Question: Author a descriptive caption for the visualization shown.
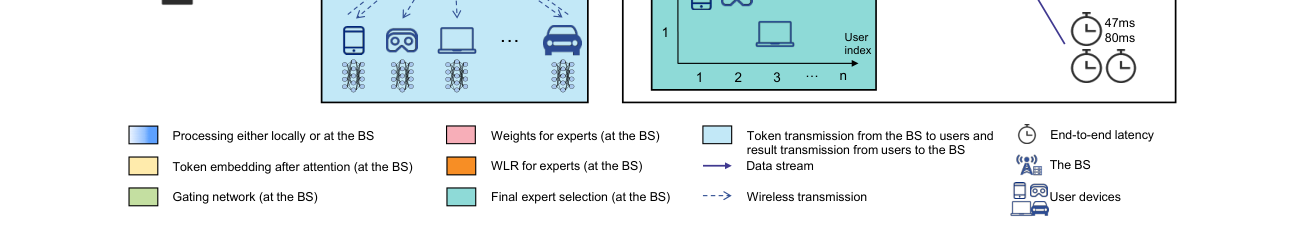
Answer: The data stream and expert selection in WDMoE. When a user sends a prompt to an MoE-based LLM, it is preprocessed, embedded, and subjected to attention operations either locally or at BS, depending on user preference. Each token’s embedding is then analyzed by a gating network to assign weights to each expert. WDMoE dynamically adjusts these weights and the number of experts based on gating network output and user channel conditions at the BS. The token embeddings are sent to the respective user devices for processing by expert networks. Once processed, the results are sent back to the BS, where they are weighted, summed, and then transformed from embeddings into words.